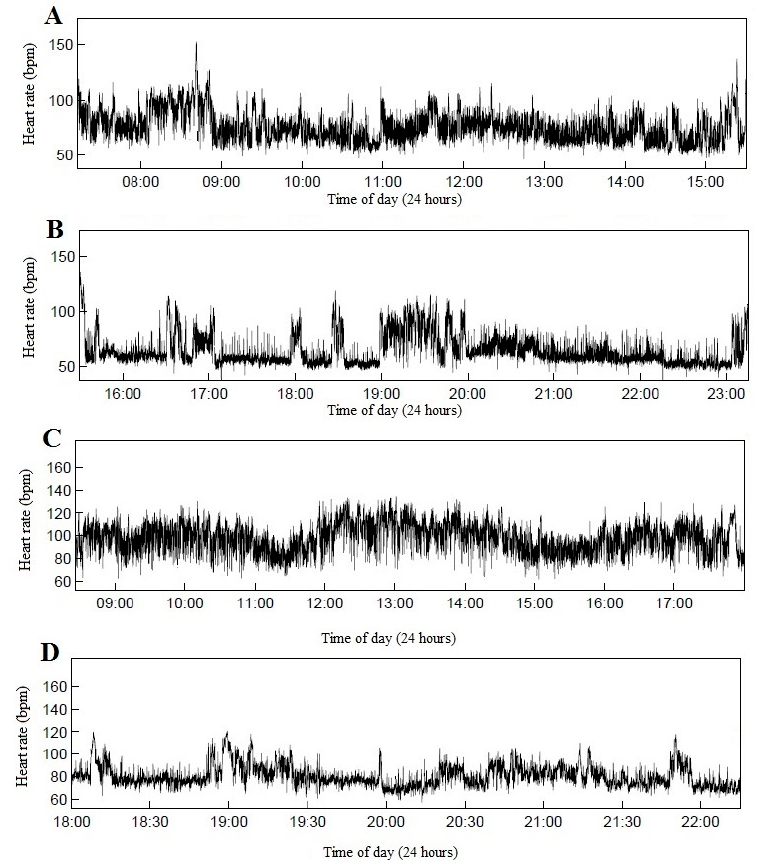
Figure 1. Examples of single periods of measured work and leisure heart rate for a foreman and a carpenter. ( A ) work foreman; ( B ) leisure foreman; ( C ) work carpenter and ( D ) leisure carpenter.